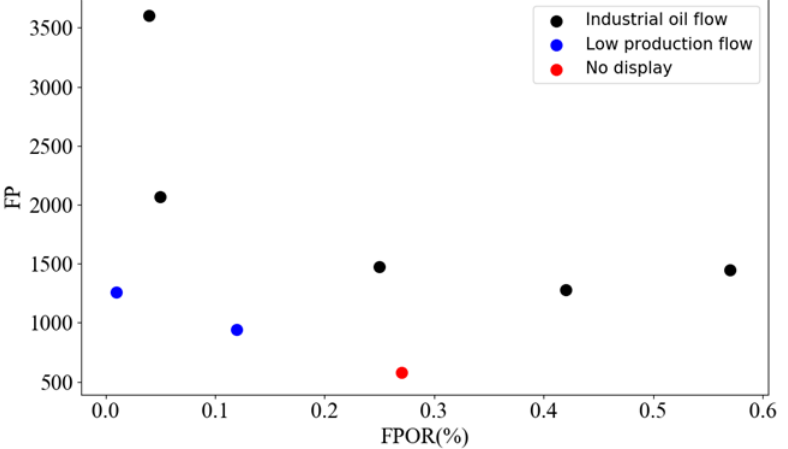
Figure 9. Cross-plot of the FPOR and FP. Figure 9. Cross‑plot of the FPOR and